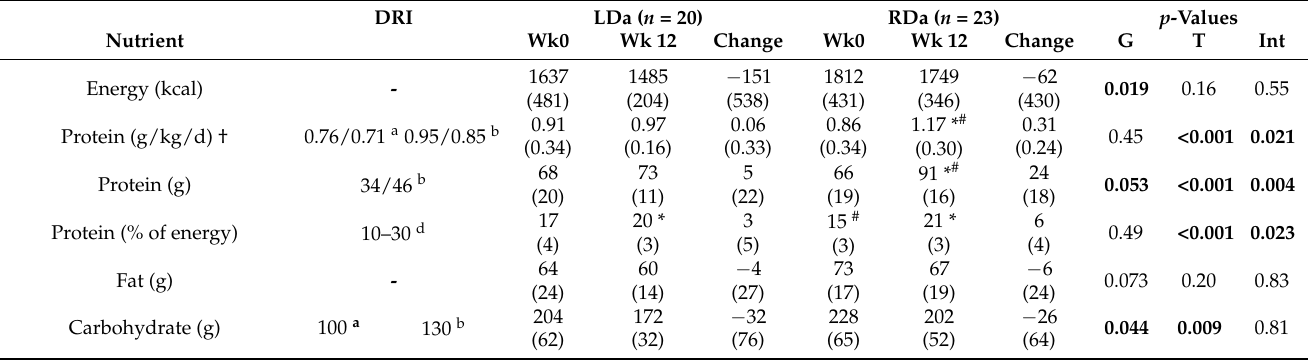
Table 4. Nutrient intake in adolescent females with overweight/obesity in the low dairy prod- uct intake (LDa) and recommended dairy product intake (RDa) groups at weeks 0 and 12 of the